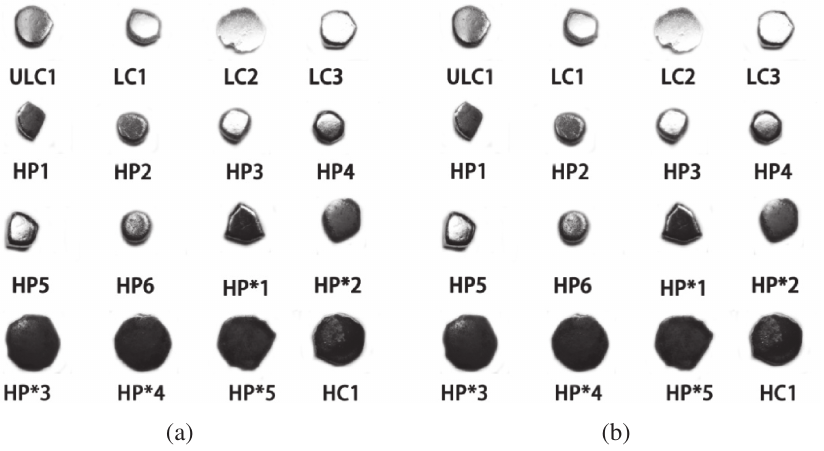
Figure 9: Appearances of solidified shell of various steels, (a) top; (b)